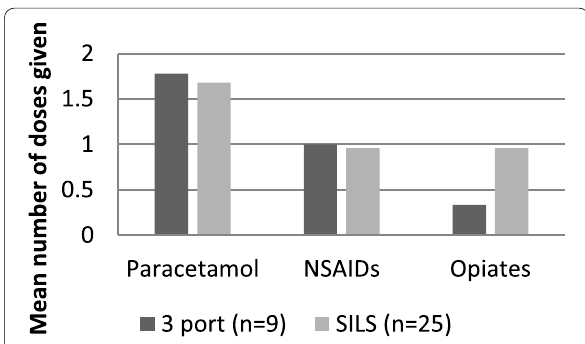
Fig. 3 Post-operative analgesia requirement for day case procedure